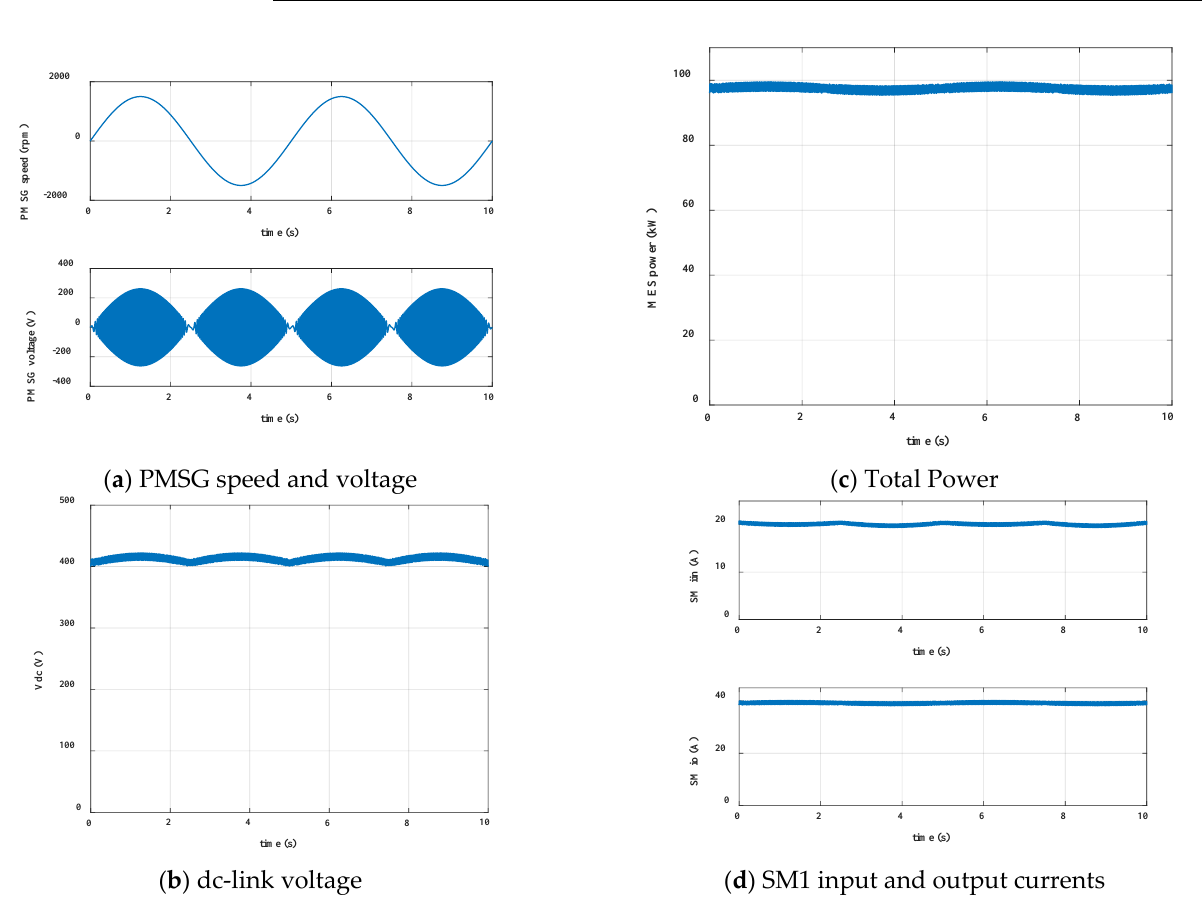
Figure 13. Mode 1 (from MES to batteries) MATLAB/SIMULINK simulations.